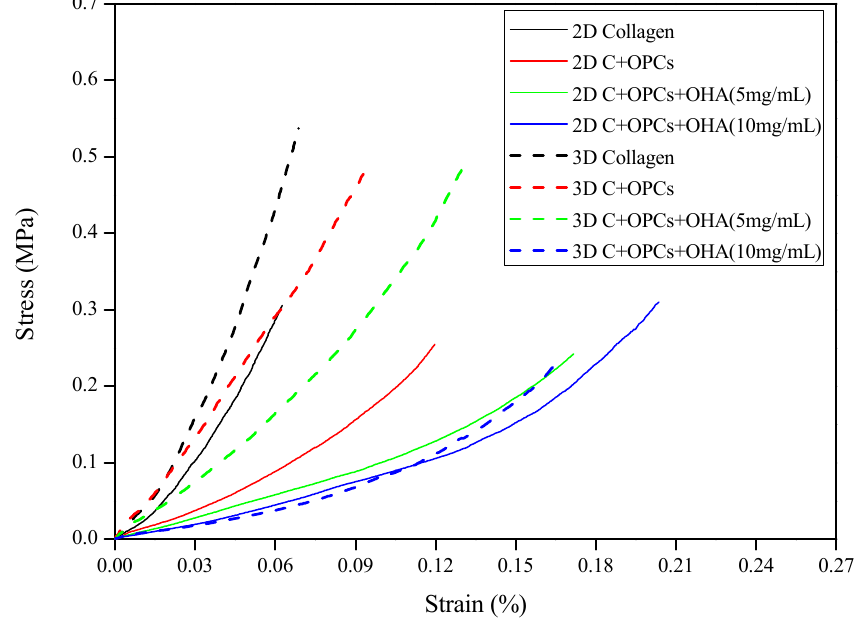
Figure 4. Compressive stress-strain curves of 2D membranes and 3D scaffolds with different concentrations of OHA.